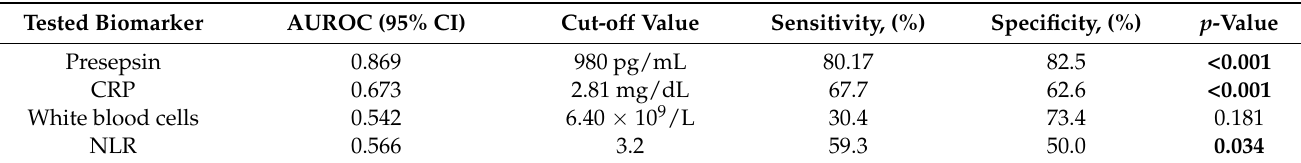
Table 4. Univariate and multivariate logistic regression analyses of factors associated with infec- tions in patients with LC and overt HE.